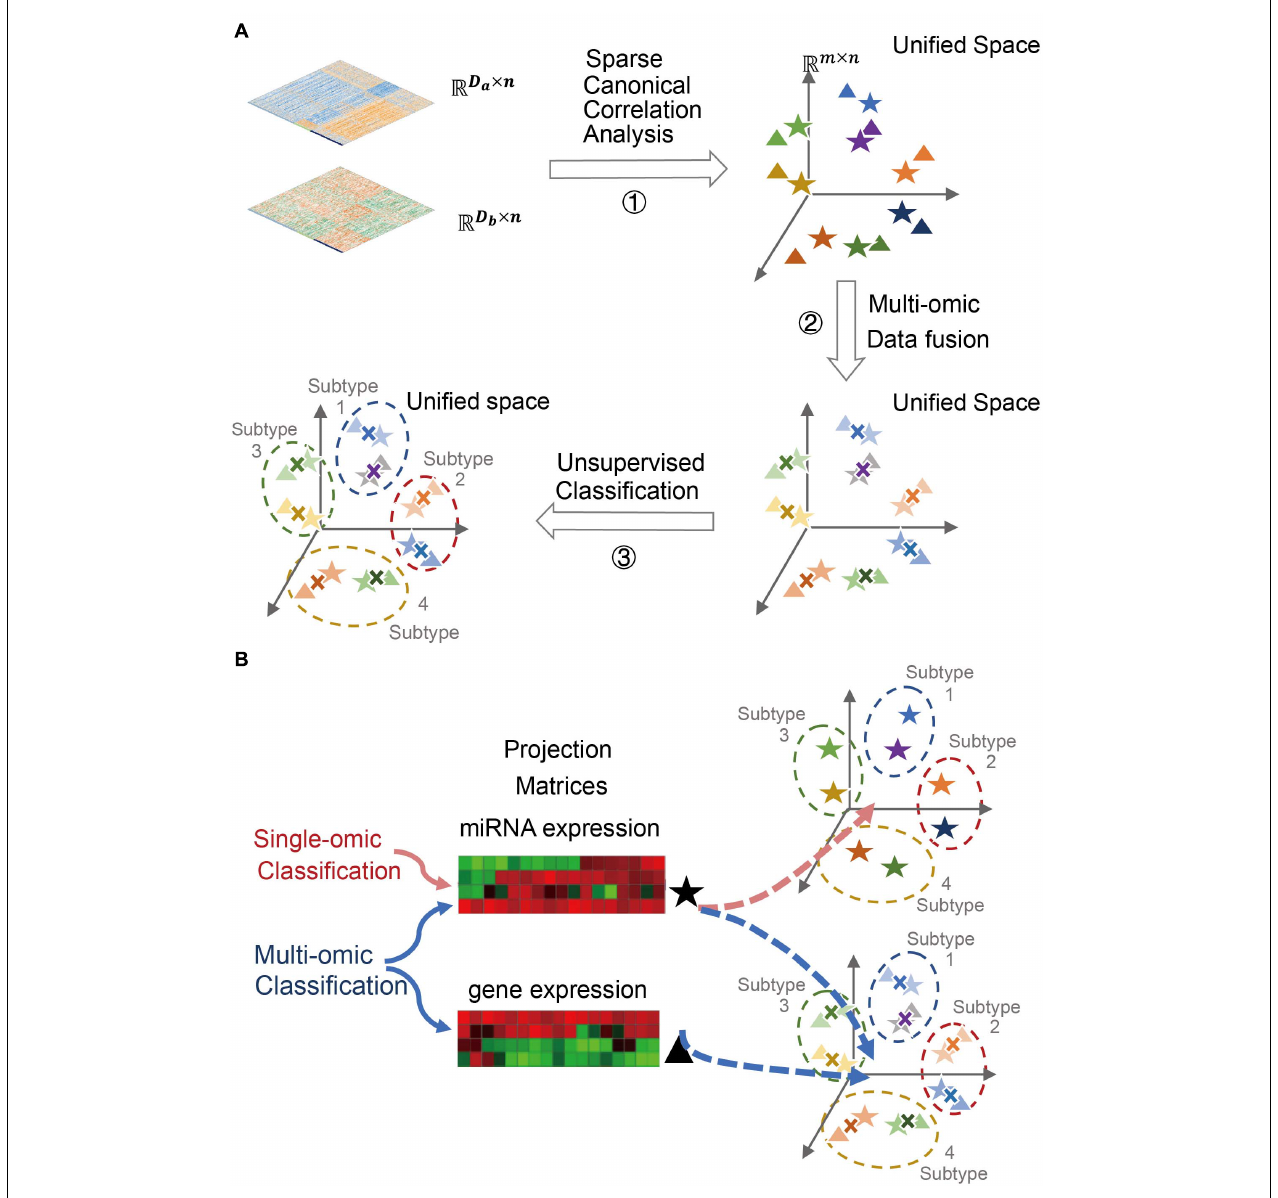
FIGURE 1 | Cancer subtyping and classification using SCCA-CC. (A) A schematic figure illustrating the three major steps for multi-omics cancer subtyping. A toy example is used to illustrate the projection of mRNA and miRNA expression data of the same set of patient samples onto lower-dimensional unified space by sparse canonical correlation analysis (SCCA), followed by data fusion and unsupervised classification. (B) A schematic figure illustrating the versatile classifier can not only classify fused multi-omics data, but also individual single-omics data.